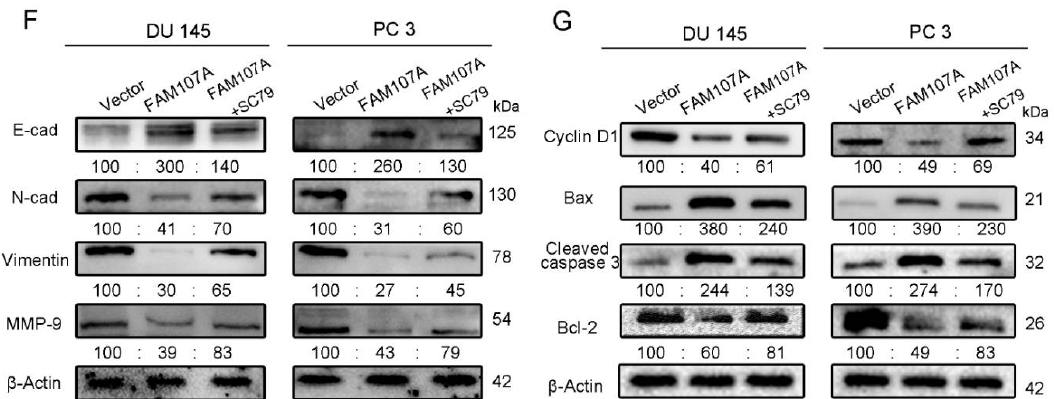
Figure 8. FAM107A affects PCa cell migration and invasion through FAK/PI3K/AKT pathway. ( A , B ) AKT activator SC79 partially restores the effect of FAM107A overexpression on cell invasion ability. The number of invading PCa cells was quantified using ImageJ software. ( C , D ) Effect of AKT activator SC79 partially restores FAM107A overexpression on wound healing assays. Wound healing was quantified using ImageJ software. ( E ) An immunofluorescence assay was used to detect the expression of Vimentin in each group of cells at a magnification of 400 × . ( F ) Western blotting analysis of changes in key proteins during EMT. ( G ) Western blotting analysis of changes in key proteins during cell cycle and apoptosis.*** for p < 0.001, and ** for p <